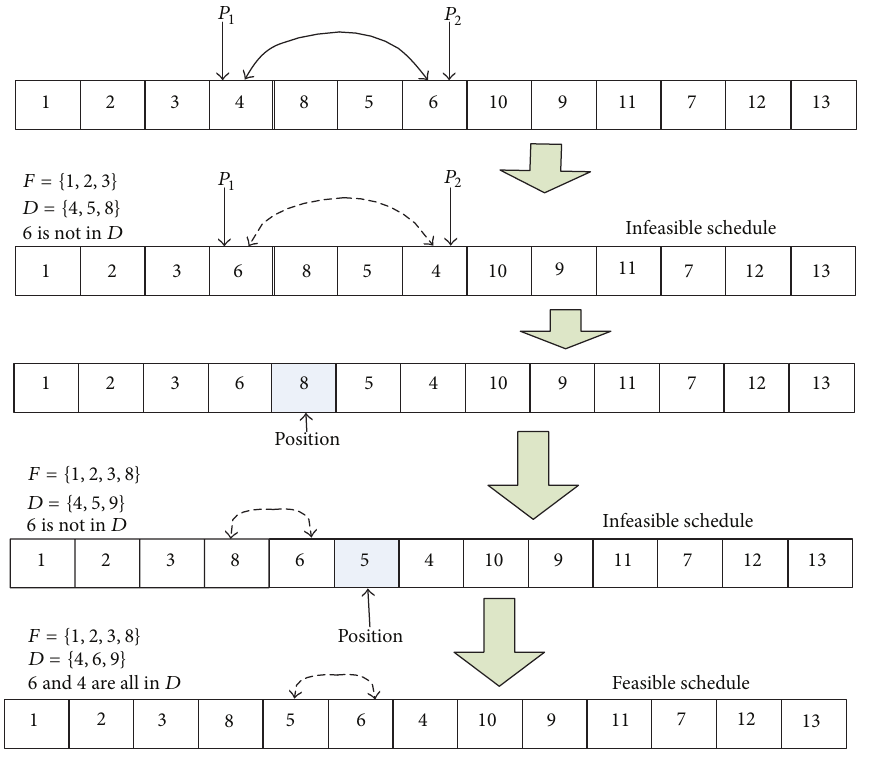
Figure 6: Detailed exhibition of repair procedure.